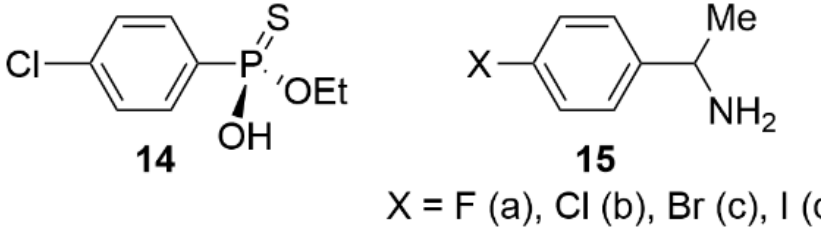
Figure 5. Structures of the chiral selector 14 and 1-(4-halophenyl)ethylamines (halo = F, Cl, Br, I) 15 .